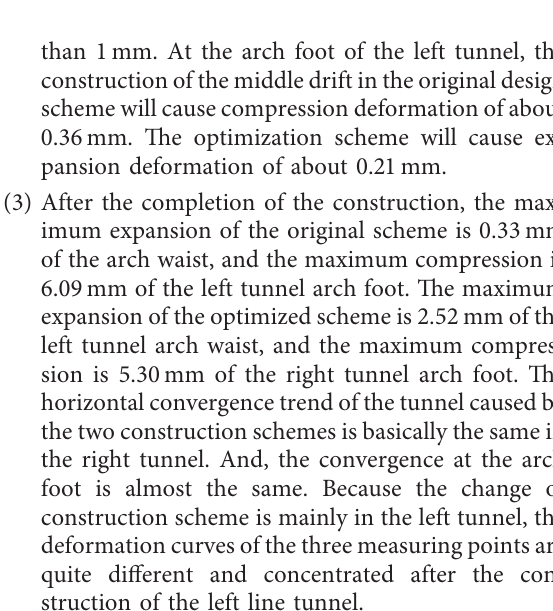
Figure 13: Comparative analysis of arch roof deformation at RK0+300: (a) right tunnel vault and (b) left tunnel